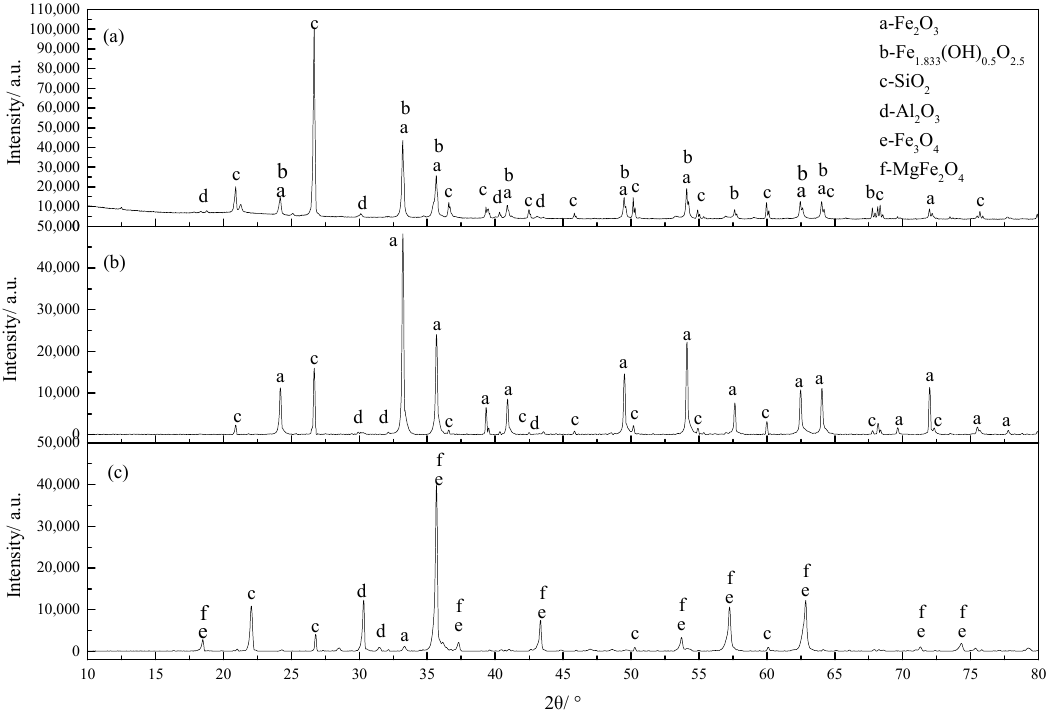
Figure 4. XRD physical phase analysis results of #1 iron ore after thermal decomposition at different temperatures. ( a ) raw material; ( b ) 750 °C; ( c ) 1350 °C.